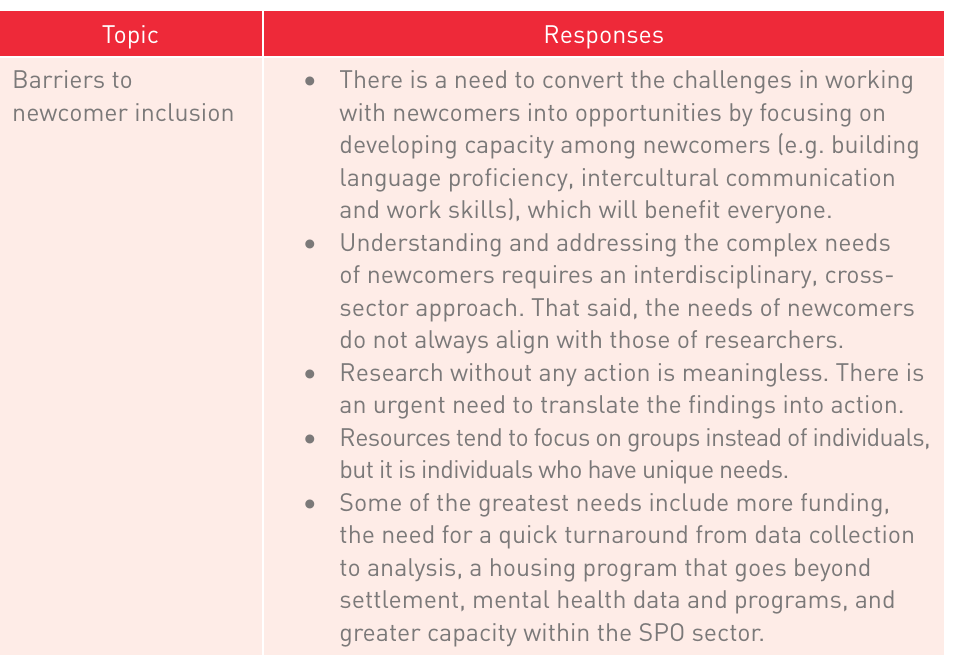
Roundtable responses by